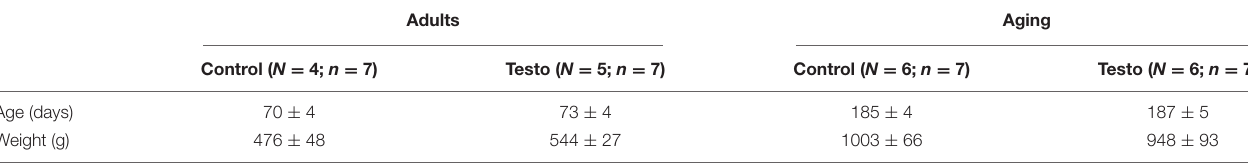
TABLE 2 | Comparison of ages and body weights of animals used for ex vivo recording of carotid body